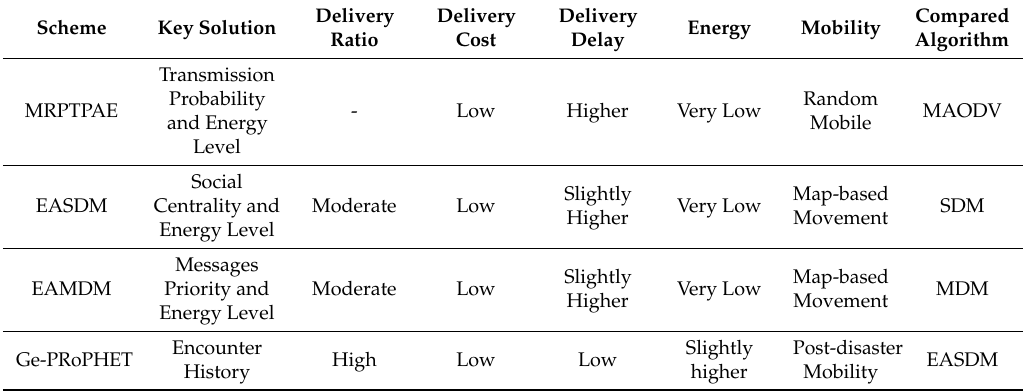
Table 3. Performance comparison of energy-aware multicast routing in